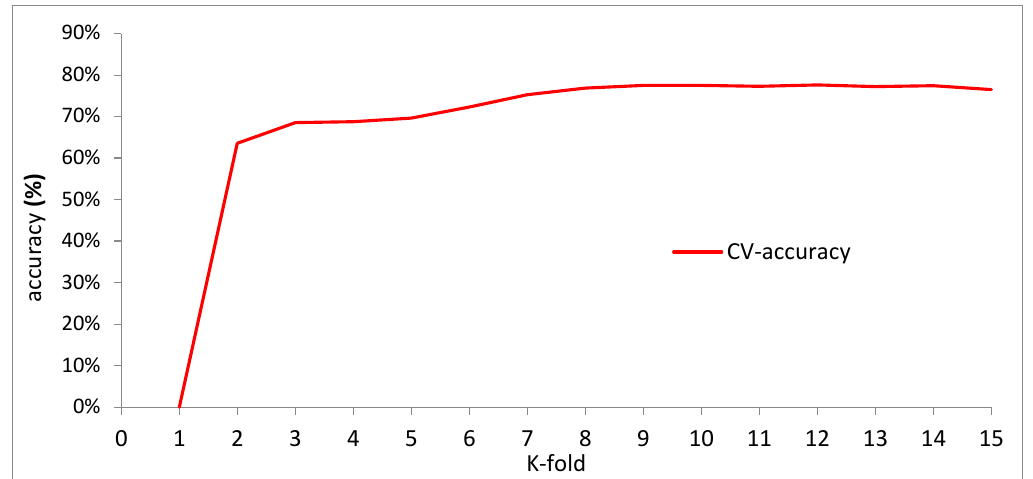
Figure 3. Accuracy of K-fold cross-validation.